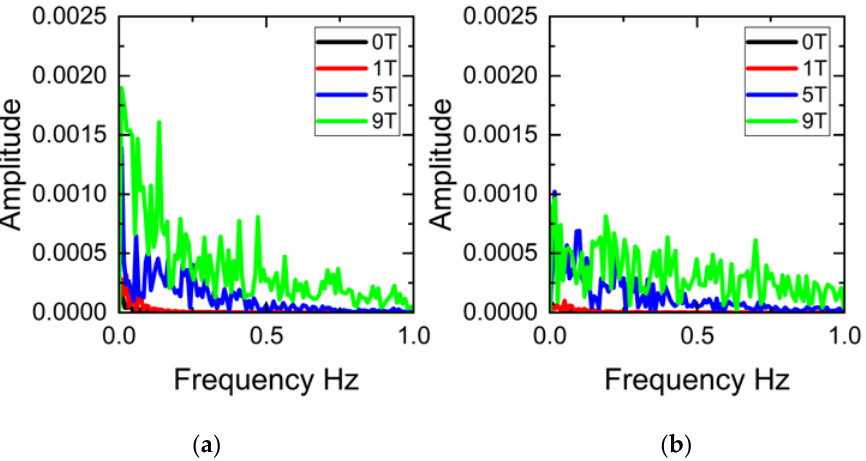
Figure 13. Fast Fourier transform results for the velocity components u ( a ) and v ( b ) for the case with ΔT = 5 °C.